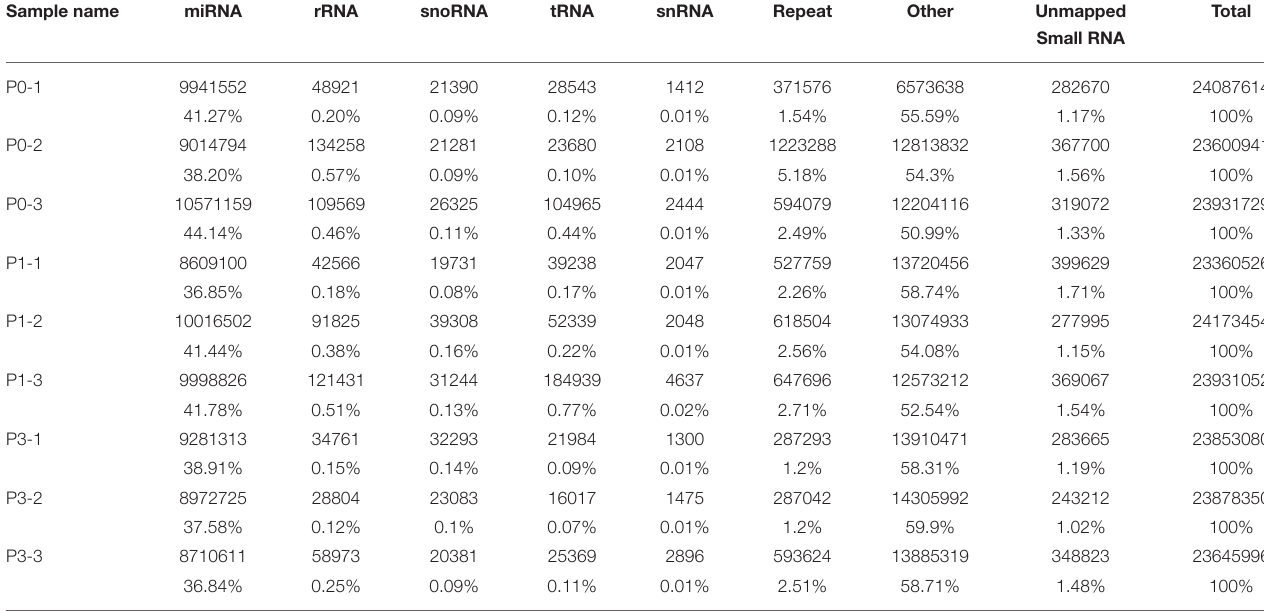
TABLE 3 | Distribution of the small RNA among different